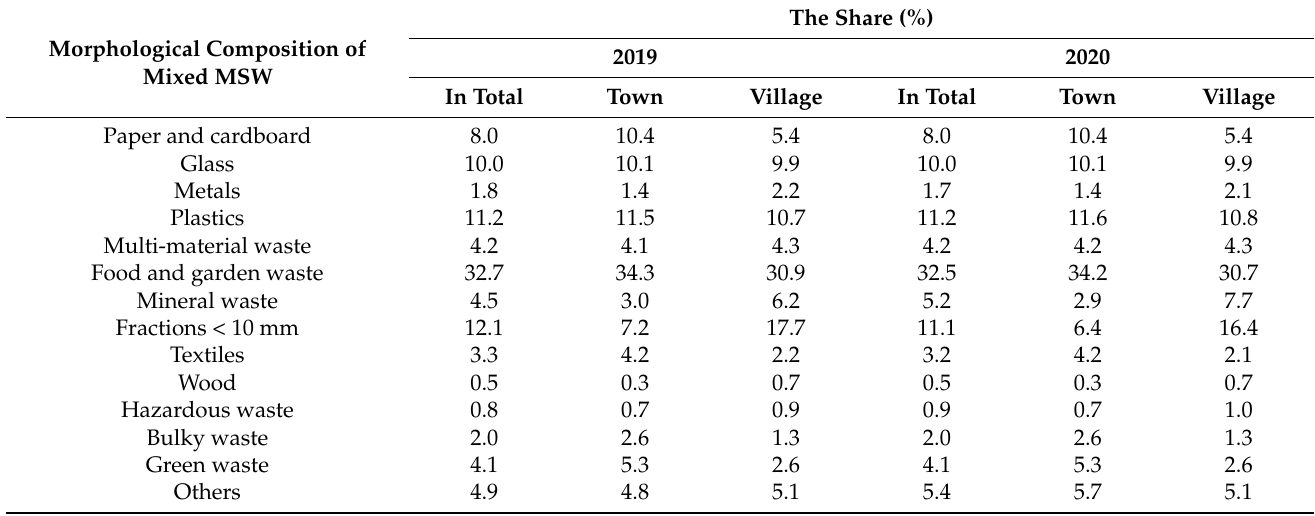
Table 2. The morphology of MSW generated in ´Swi˛etokrzyskie Voivodship